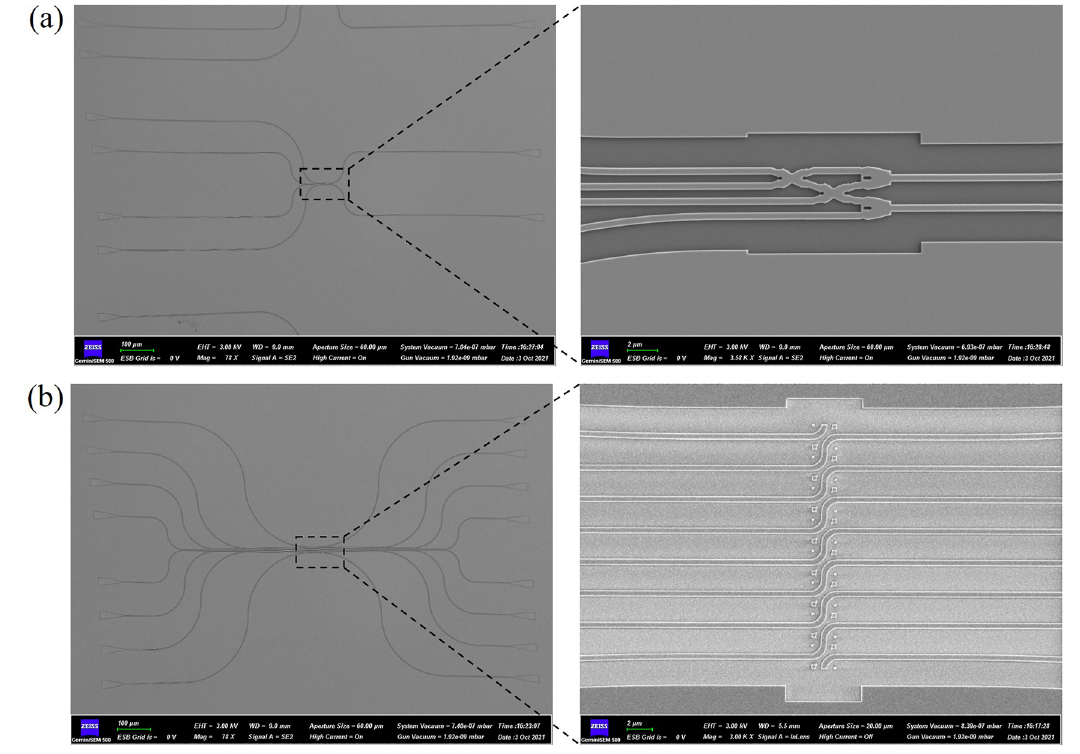
Figure 7: SEM image of the all-optical calculation part. (a) SEM image of the all-optical half binary adder. (b) SEM image of the all-optical binary